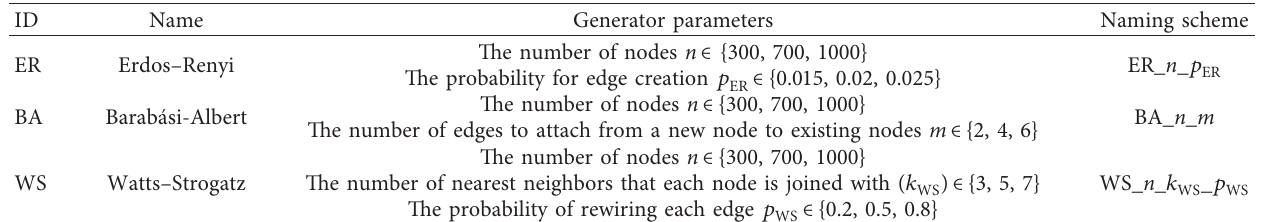
Table 2: Overview of generated random network